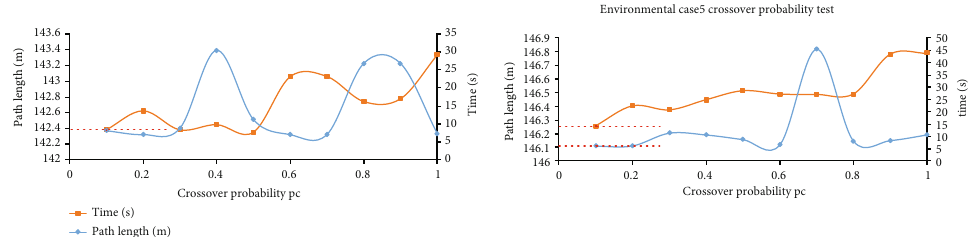
Figure 12: In fl uence of parameter pc on path length and time.